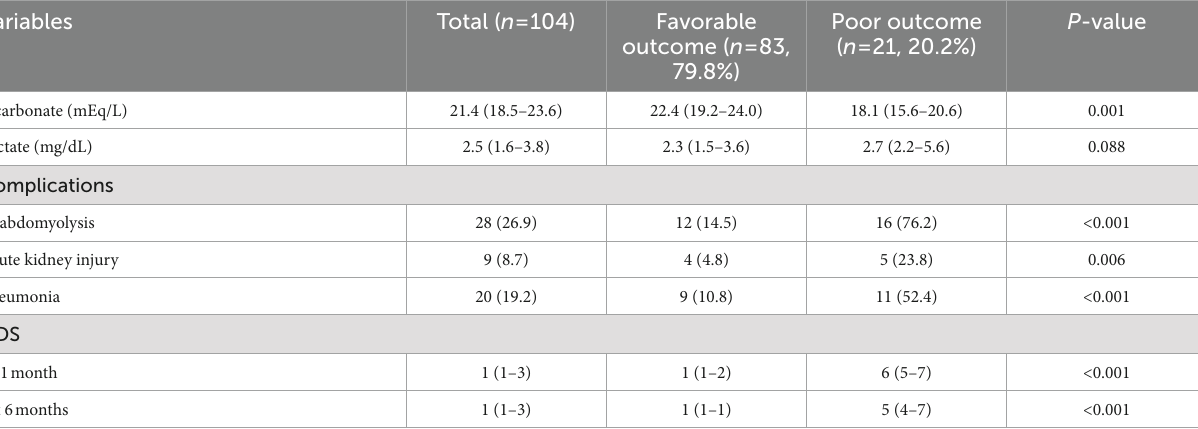
TABLE 2 Pupillometer data recorded at initial and serial evaluations after carbon monoxide poisoning categorized according to outcome groups. Variables